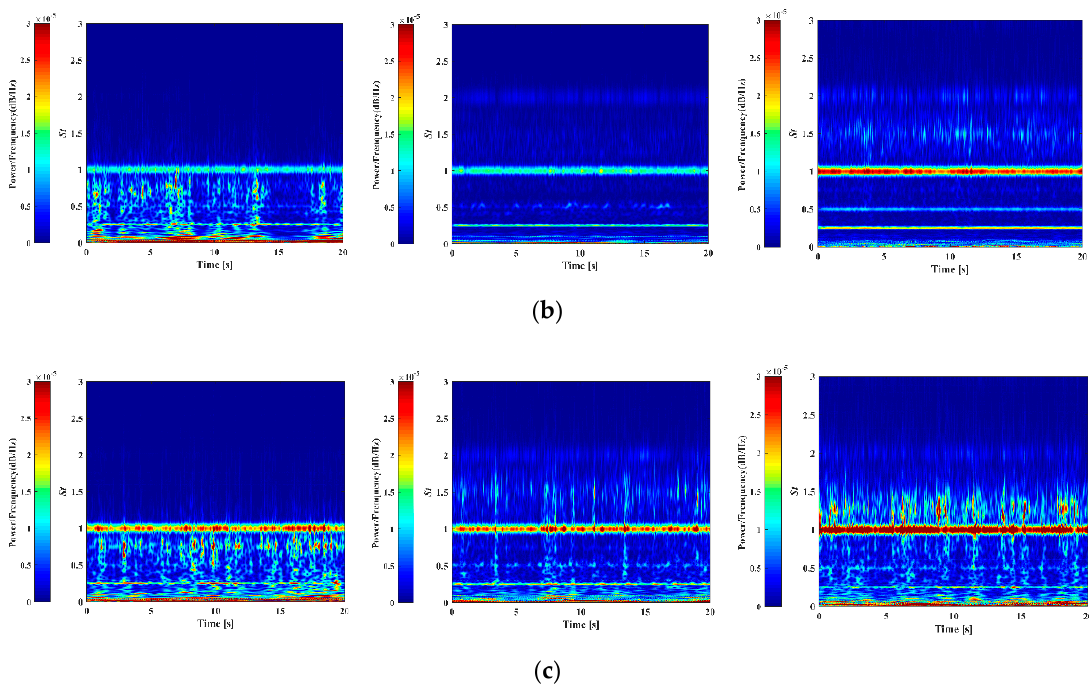
Figure 13. Time ‐ frequency domain of pressure pulsations for three schemes at H d = 4.7 m: ( a ) P1; ( b ) P2; ( c ) P3 (Each row from left to right is H = 204 mm, 164 mm and 142 mm).